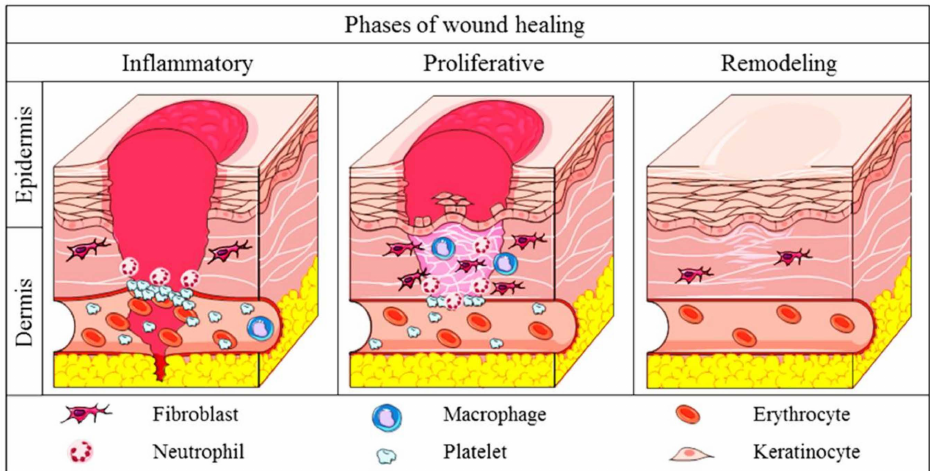
Figure 2. Stages of cutaneous wound healing in mammals. Figure is reused under the permission obtained from Creative Commons Attribution-ShareAlike License